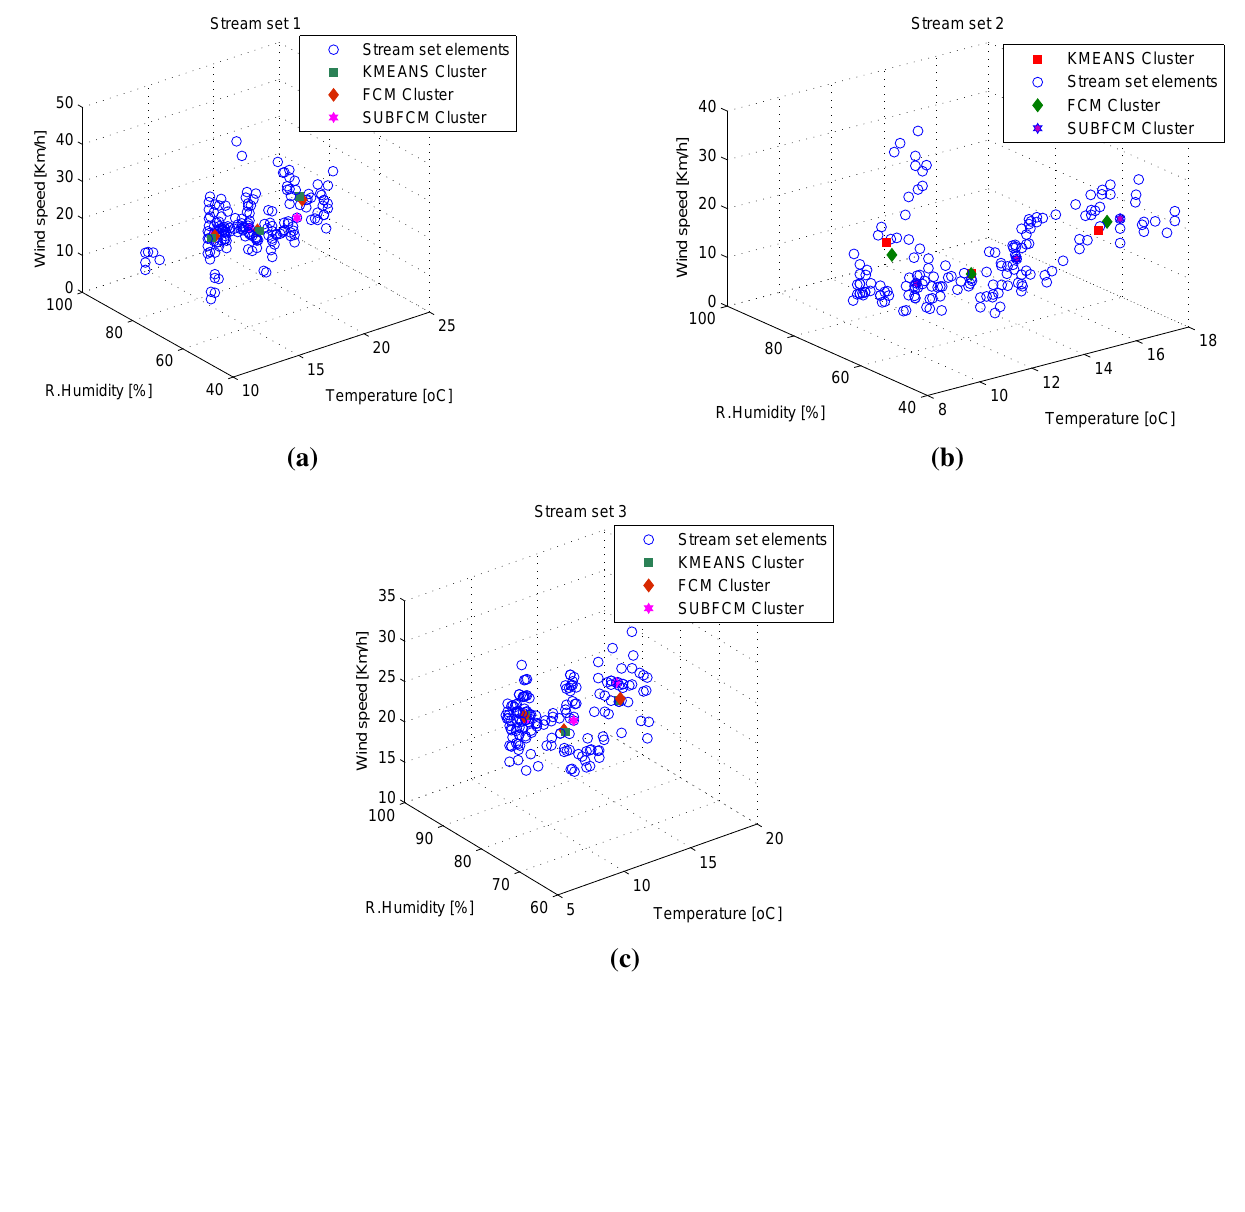
Figure 7. Stream sets and clusters for the first three stream sets. ( a ) Stream sets and clusters for the first stream set; ( b ) stream sets and clusters for the second stream set; ( c ) stream sets and clusters for the third stream